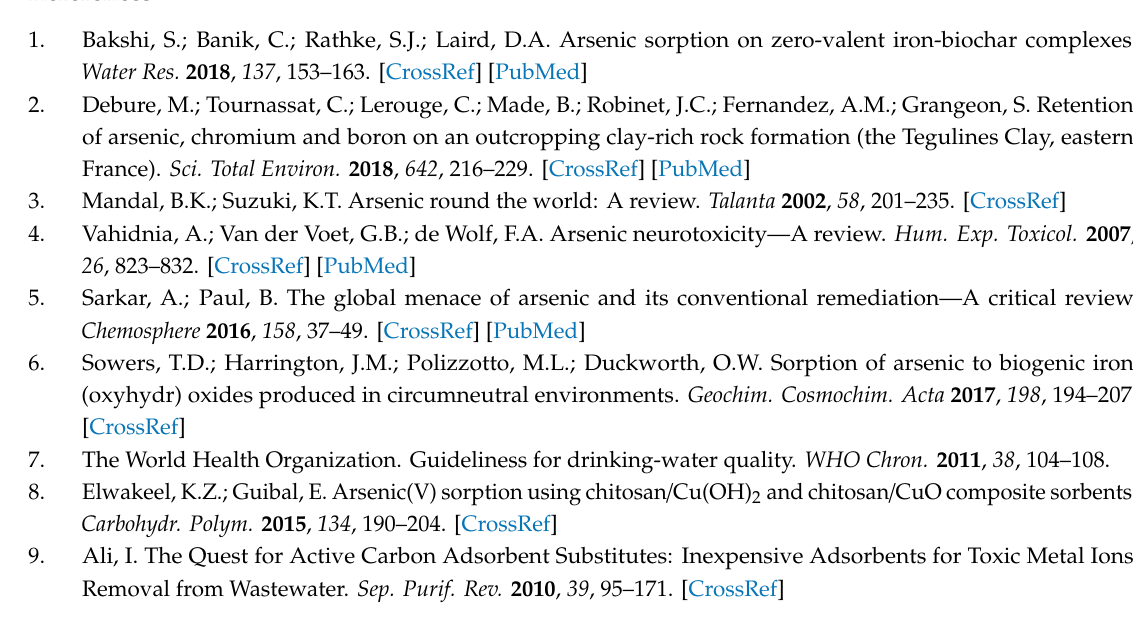
Figure S1: Changes of pH value measured in solutions of As(III) (a) and As(V) (b) before and after sorption experiment carried out onto diverse initial pH value of raw and modified vermiculite. Figure S2: Changes of pH value measured in solutions of As(III) (a) and As(V) (b) before and after sorption experiment carried out onto diverse initial concentration of raw and modified vermiculite. Figure S3: Changes of pH value measured in solutions of As(III) (a) and As(V) (b) before and after sorption experiment carried out onto diverse dosage of raw and modified vermiculite. Figure S4: Linearization of Freundlich and Langmuir model for sorption of As(III) (a), As(V) onto raw vermiculite (b); sorption of As(III) (c), As(V) onto 0.5 HDTMA (d) and As (III) (e), As(V) onto 0.5 HDBA (f); As(III) (g), As(V) onto 1.0 HDTMA (h) and As(III) (i), As(V) onto 1.0 HDBA (j); sorption of As(III) (k), As(V) onto 2.0 HDTMA (l) and As(III) (m), As(V) onto 2.0 HDBA (n). Table S1: Freundlich and Langmuir model coe ffi cients for sorption of As(III) and As(V) onto raw and modified